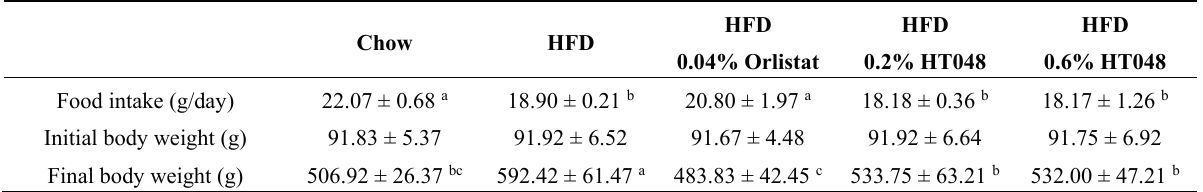
Table 1. Effect of HT048 on body weight and food intake in rat fed HFD for 12 weeks. Chow HFD